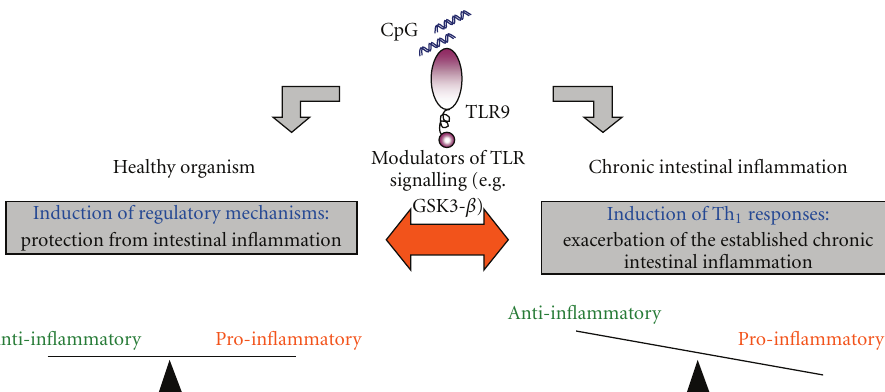
Figure 1: Whereas in a healthy organism under steady-state conditions CpG DNA/TLR9 activation favours the induction of regulatory mechanisms in chronic intestinal inflammation CpG/TLR9 interaction contributes to the perpetuation of chronic intestinal inflammation. The identification of possible regulators of TLR9 activation (e.g. GSK3- β ) which have the potential to decide whether TLR activation results in a more tolerizing or proinflammatory response may help to explain these dichotomic e ff ects. These regulators are interesting targets for therapeutic